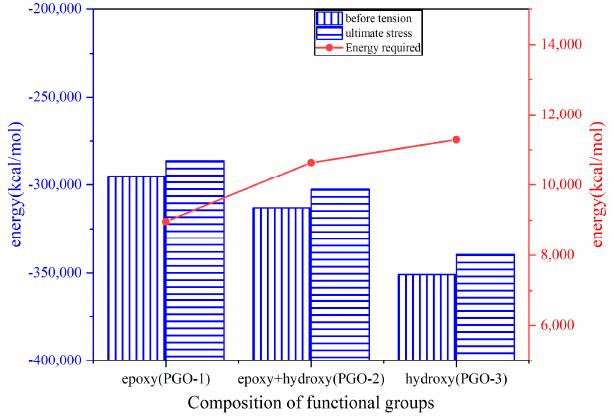
Figure 9. Energy change of PGO during the tensile process.